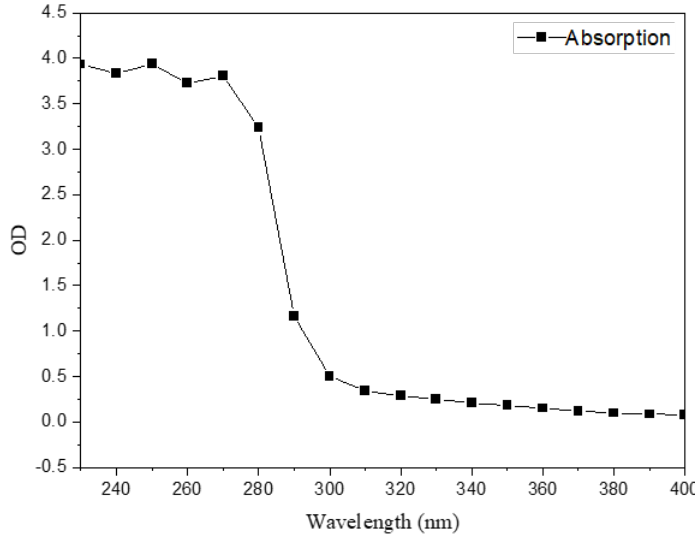
Figure 5. Full band scanning results of FS.